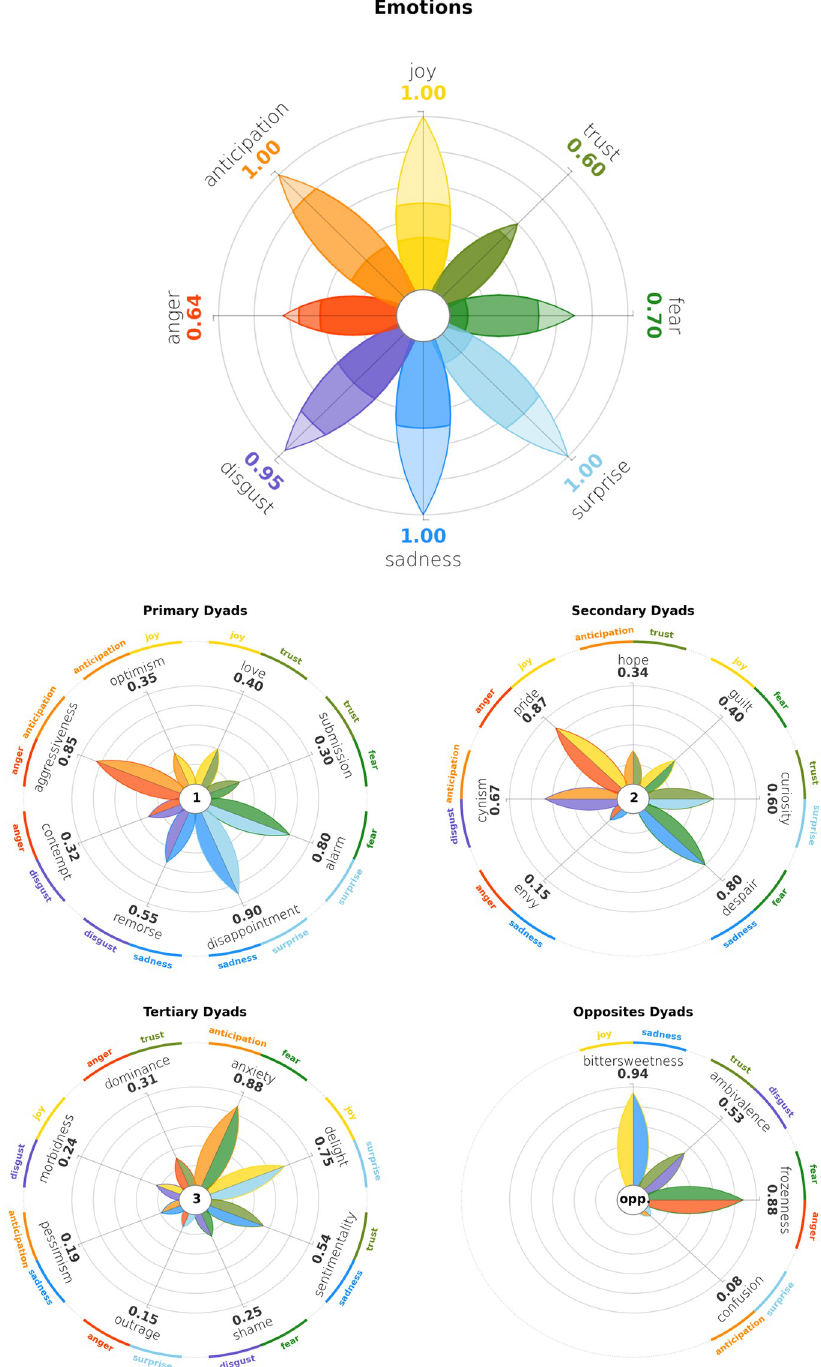
Fig 9. Representation of emotions and primary, secondary, tertiary and opposite dyads. The data displayed is random.